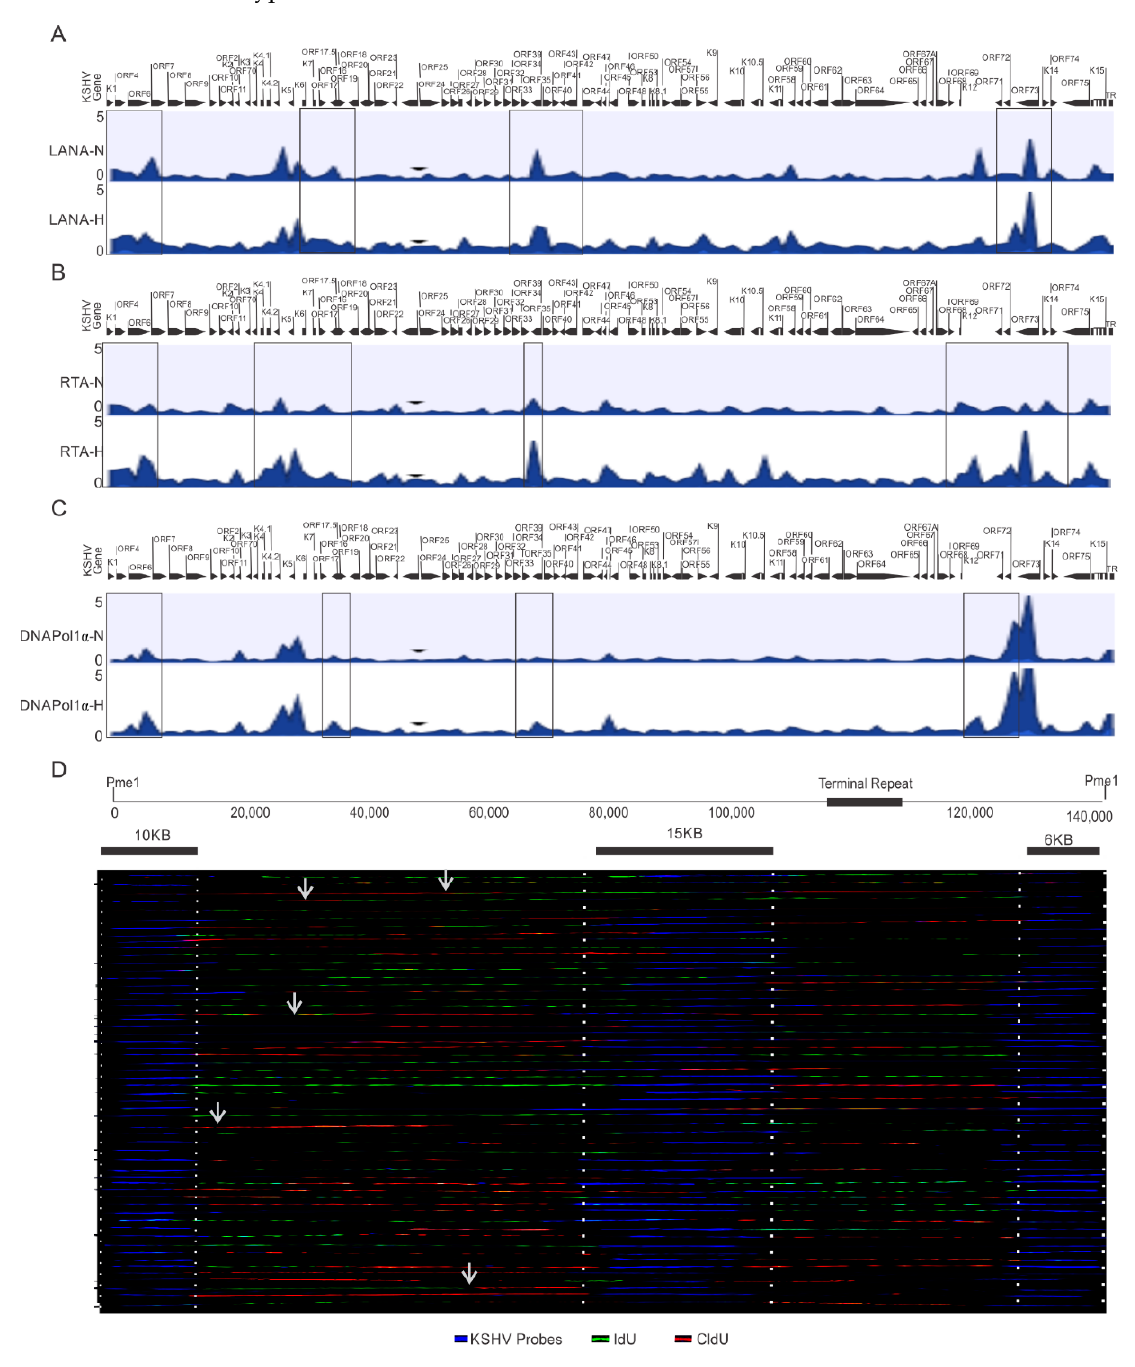
Figure 4. Identification of preferential regions of the KSHV genome for initiation of replication under hypoxic conditions. ( A – C ) Differential enrichment of LANA, RTA, and DNA Polymerase 1 α on the KSHV genome in normoxic and hypoxic conditions. A complete list of statistically significant